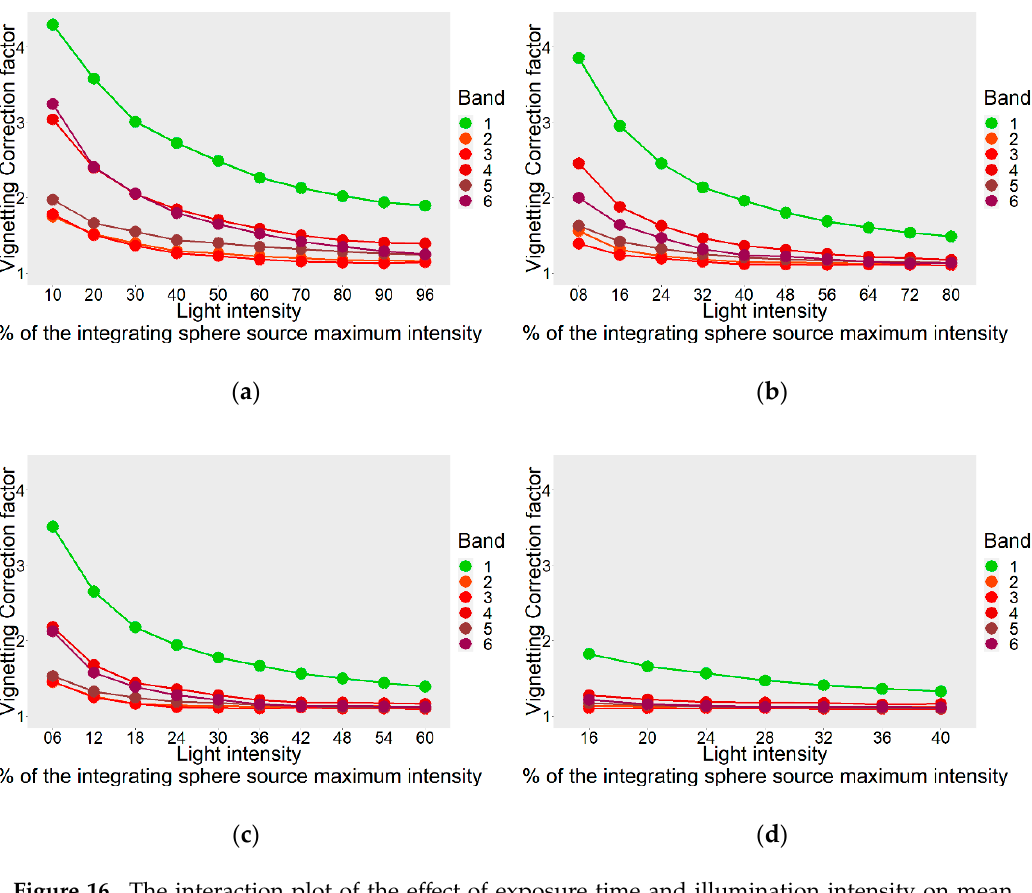
Figure 16. The interaction plot of the effect of exposure time and illumination intensity on mean correction coefficient: ( a ) Exposure time 50 μ S; ( b ) Exposure time 250 μ S; ( c ) Exposure time 500 μ S; ( d ) Exposure time 1000 μ S.